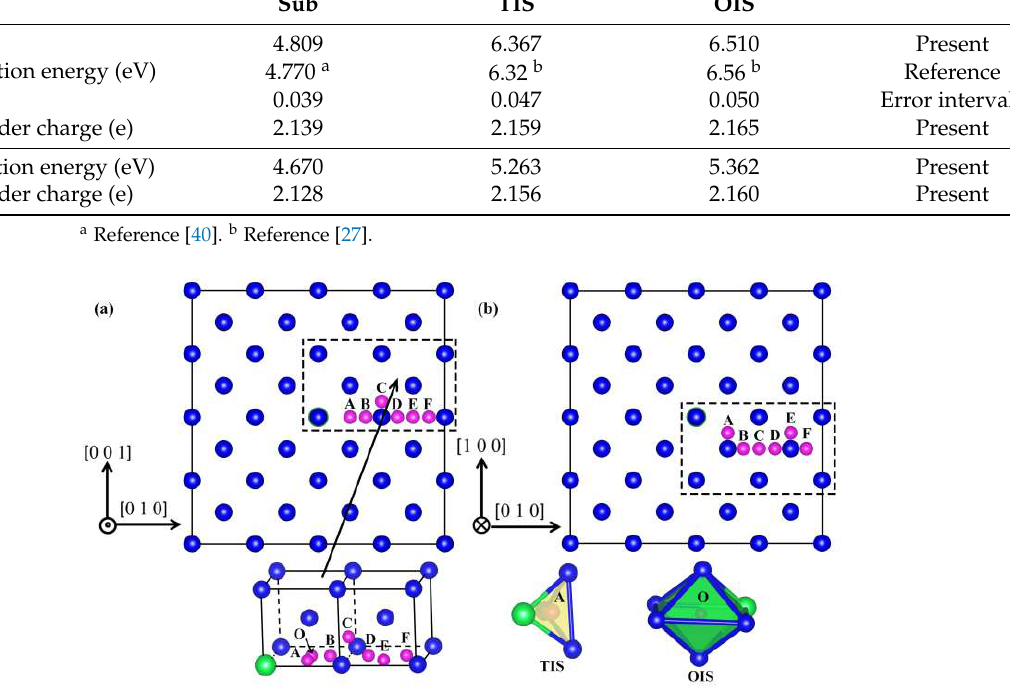
Figure 1. ( a , b ) Schematic top and side views of the bulk W-Y system, respectively. Here, A–F and O represent seven different interstitial sites, and the local 3D configuration represents the spatial structure of the interstitial sites (TIS and OIS). Here, the blue, green, and purple balls represent W, Y, and He, respectively.